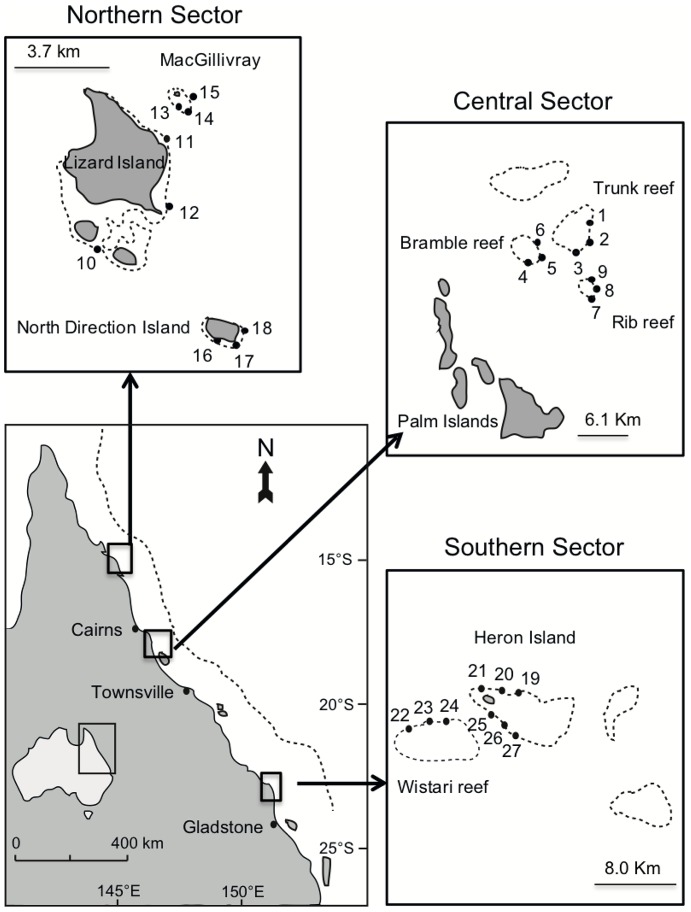
Map of the three study sectors (northern, central and southern) along the Great Barrier Reef, Australia.Within each latitudinal sector, three mid-shelf reefs, each with three sites on the exposed reef crest, were sampled. Figure adapted from Trapon and co-workers [18].